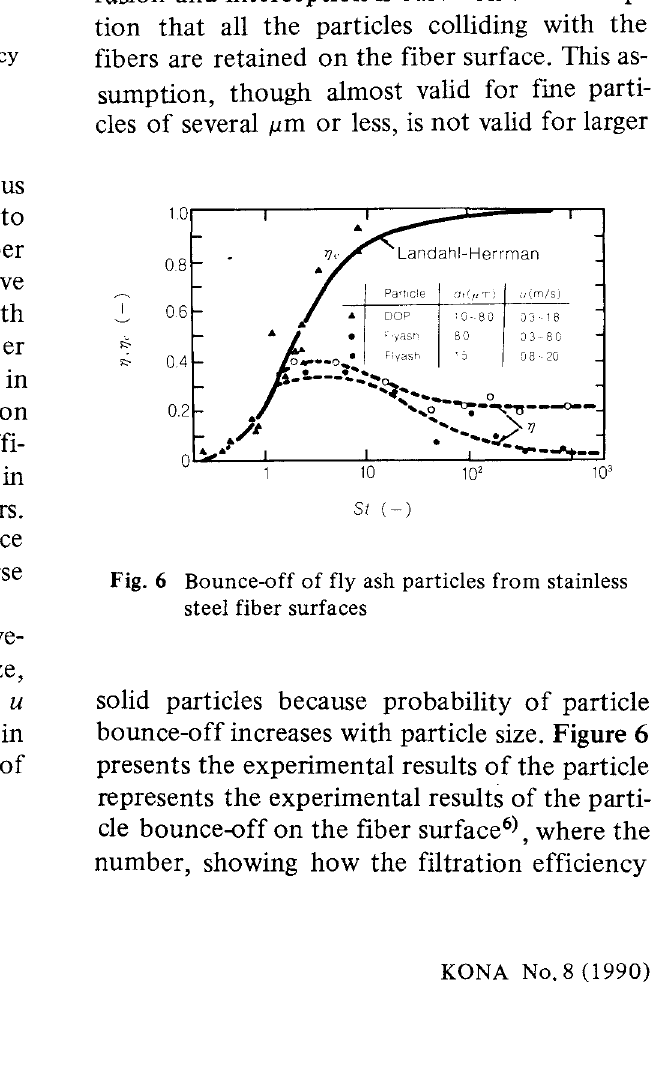
Fig. 5 Dependence of particle penetration of an ultra high performance filter on the filtration velocity (dr: 0.76 pro, L: 0.395 mm, o:: 0.075)